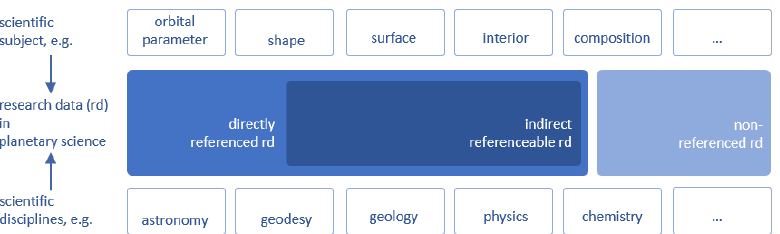
Figure 1. Schematic overview of scientific disciplines and different research data within planetary research. We mentioned that the area of research data also includes scientific publications such as research